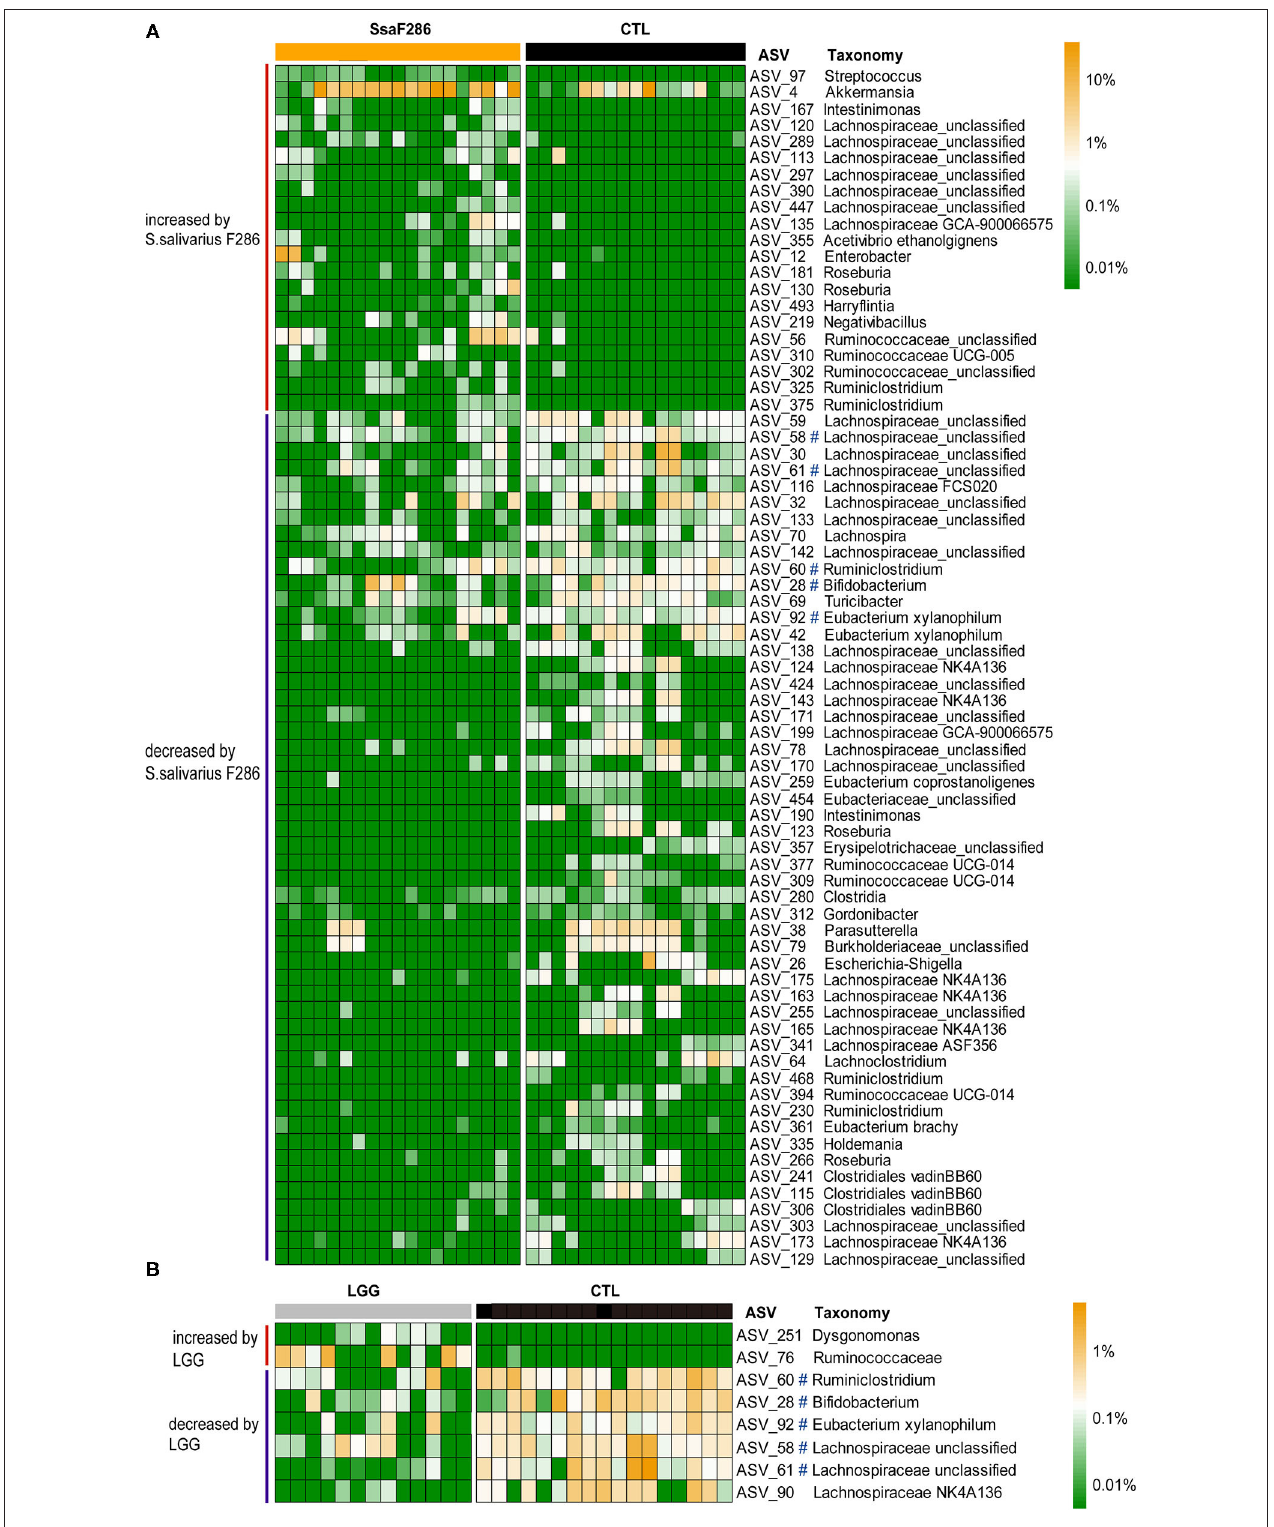
FIGURE 3 | ASVs changed by S. salivarius F286 and LGG at the age of 3 weeks. (A) Heatmap of the normalized and log 10 -transformed relative abundance of 73 ASVs changed by S. salivarius F286 in each sample. (B) Heatmap of the normalized and log 10 -transformed relative abundance of 8 ASVs changed by LGG in each sample. The taxonomy of the ASVs is shown. # ASVs decreased by both S. salivarius F286 and LGG. CTL, Control group; SsaF286, S. salivarius F286 group; LGG, LGG group.